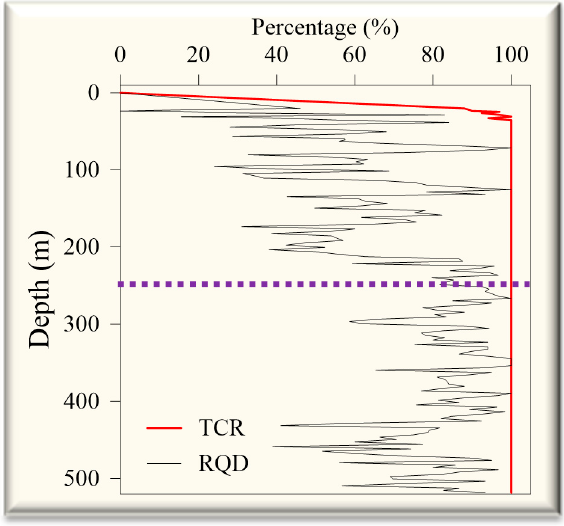
Figure 4. Rock quality designation (RQD) and total core recovery (TCR) data from the study site.